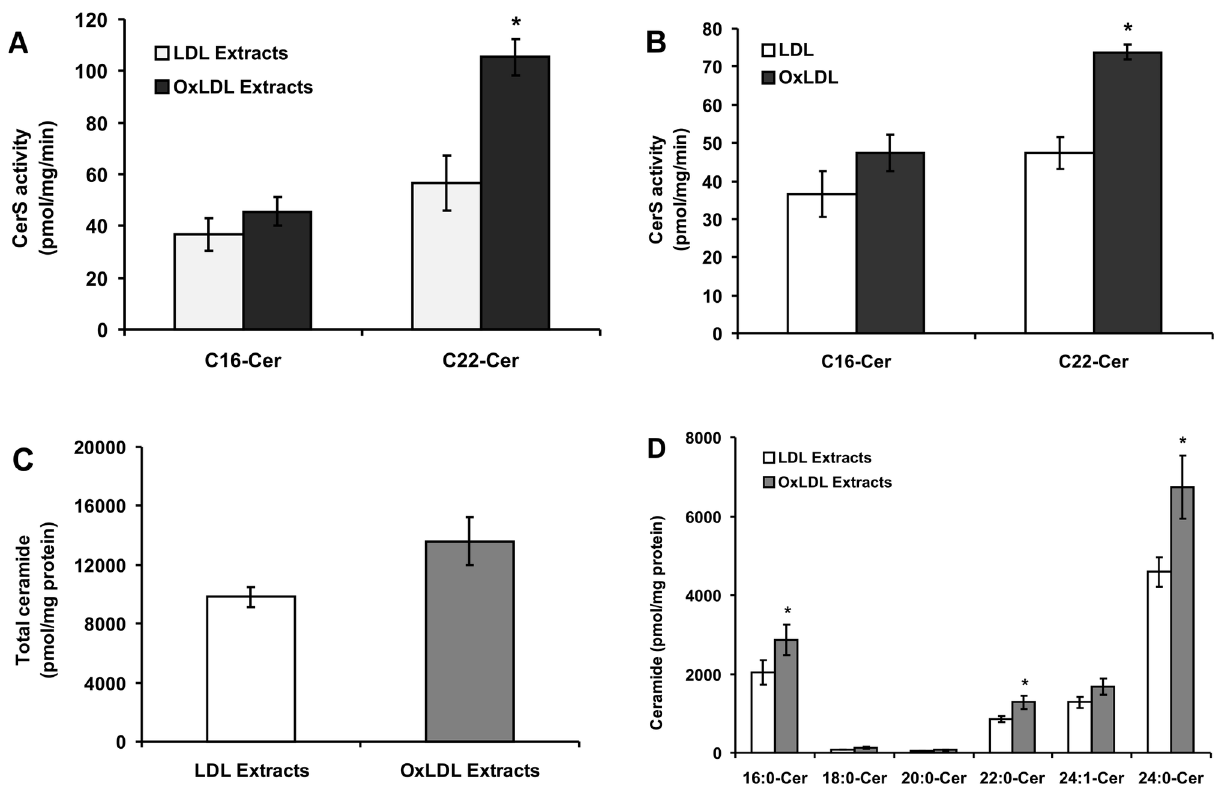
Figure 5. Effect of lipid extracts from LDL and OxLDL on CerS activity. (A) Oxidation of LDL was performed as described under “Experimental Procedure”. RAW 264.7 cells were stimulated with lipid extracts from native LDL and OxLDL (50 µg protein/mL respectively) for 24 h. CerS activity in cell homogenates was measured using C ± S.D., *p < 0.05, of a typical experiment repeated four times with similar results. (B) Cells were treated with intact LDL and OxLDL (50 µg protein/mL respectively) as described above for 24 h. CerS activity in cell homogenates was measured using C C -CoA substrates. Results are means ± S.D. *p < 0.05, of a typical experiment repeated four times with similar results. (C) Cells 22 were treated as described above and lipids were extracted and analyzed for ceramide content as described under “Experimental Procedure”. No probability values are given for total ceramide levels because these levels are the sum of ceramide species with different acyl chain lengths. (D) Ceramide species were analyzed after treatment with lipid extracts from native LDL and OxLDL as described earlier. The data are means ± S.E., *p < 0.05, n =